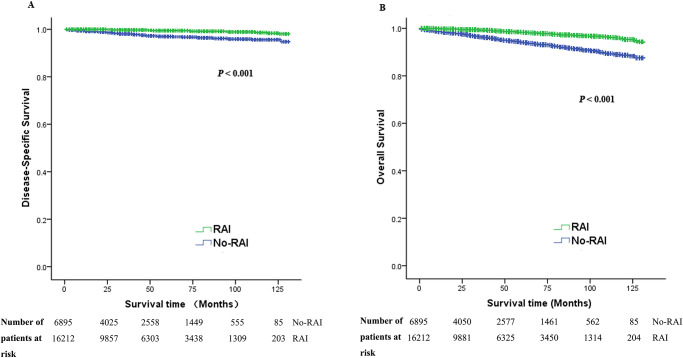
Unadjusted disease-specific survival (A) and overall survival (B) difference for intermediate-risk PTC patients according to RAI therapy.